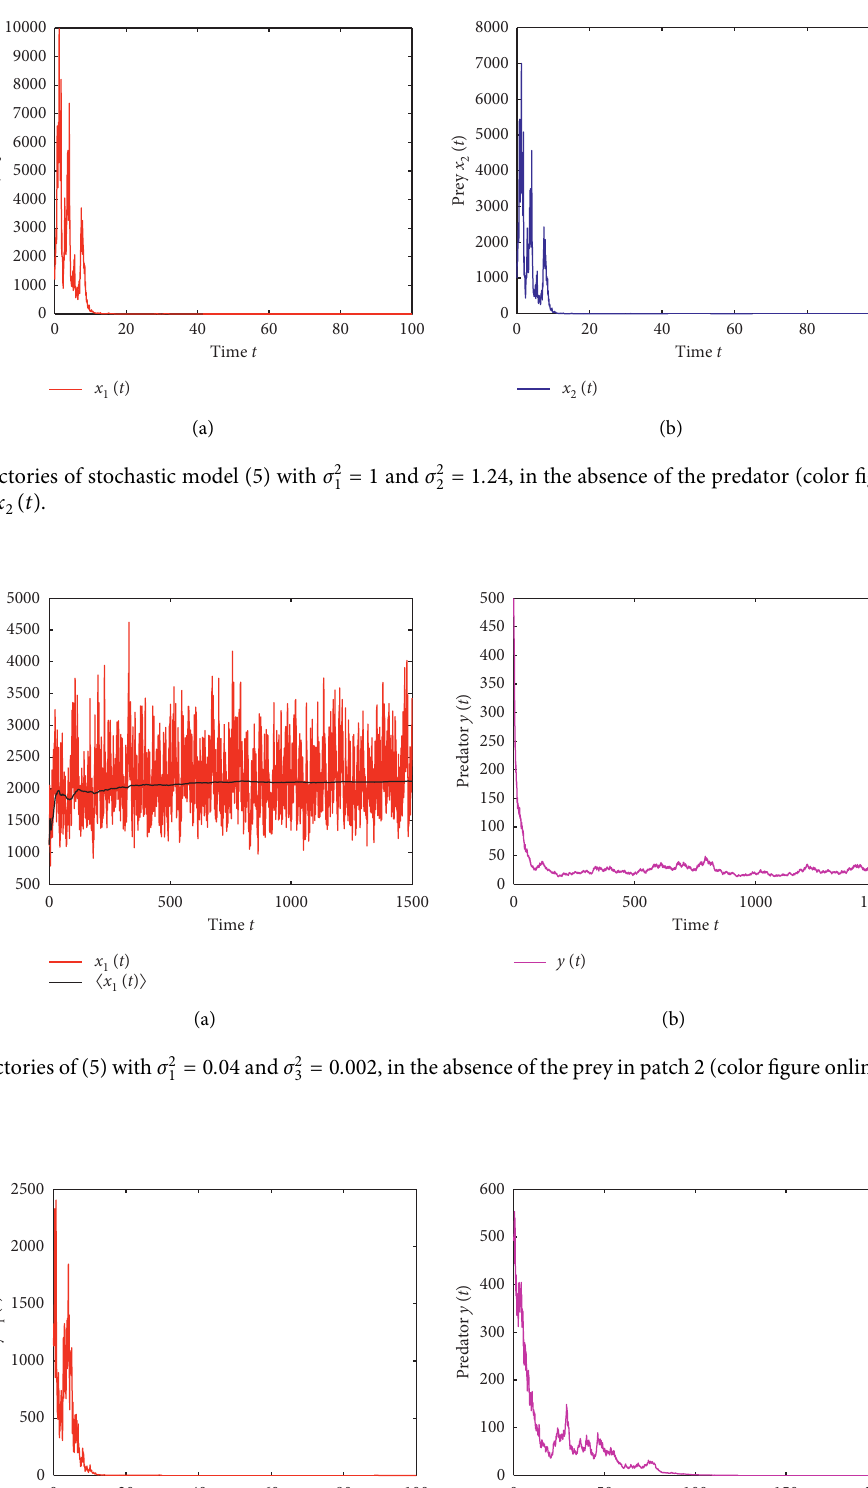
� 1 and σ 2 � 0 . 04, in the absence of the prey in patch 2 (color figure online): (a) prey x 1 3